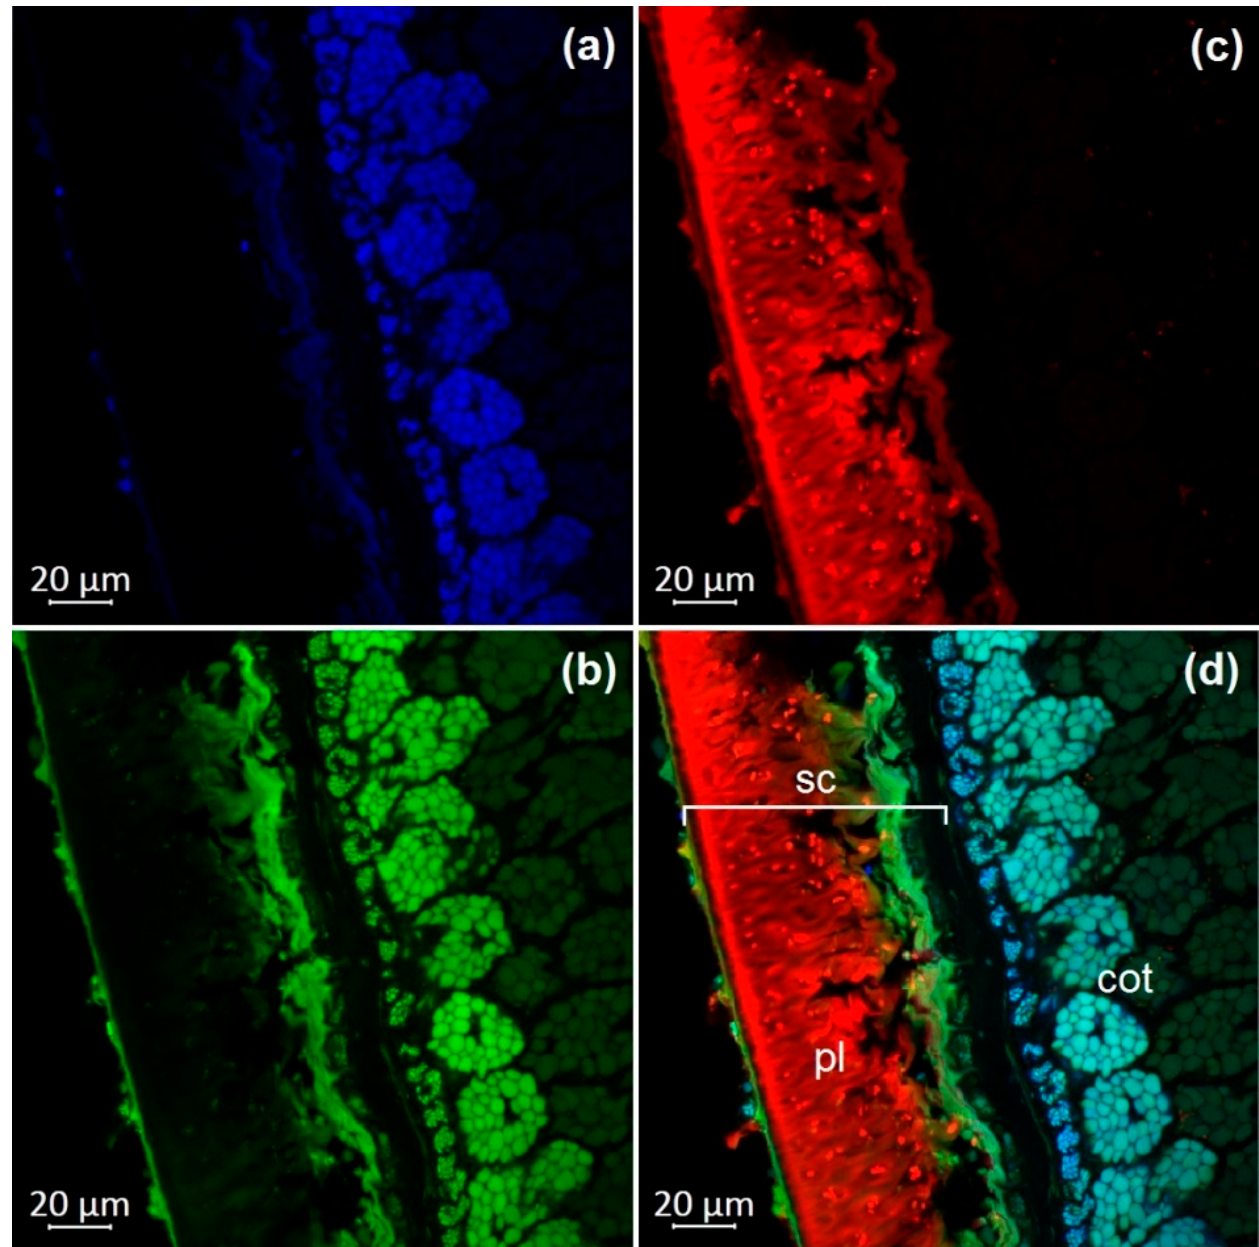
Figure 3. A transverse section of a soybean seed (variety k-11559): ( a ) excitation at 405 nm with emission in the range of 400–475 nm (blue); ( b ) excitation at 488 nm with emission in the range of 500–545 nm (green); ( c ) excitation at 488 nm with emission in the range of 620–700 nm (red); ( d ) merged; cot, cotyledon; pl, palisade layer; sc, seed coat. In general, our study showed the maximum of blue fluorescence, which reflects the content of hydroxycinnamic acids, in the outer cotyledon layer. A weaker signal was observed in the rest of the cotyledon parenchyma cells. In the seed coat of the dark-colored seeds, the signal was almost absent. On the contrary, the light-colored seeds (yellow)